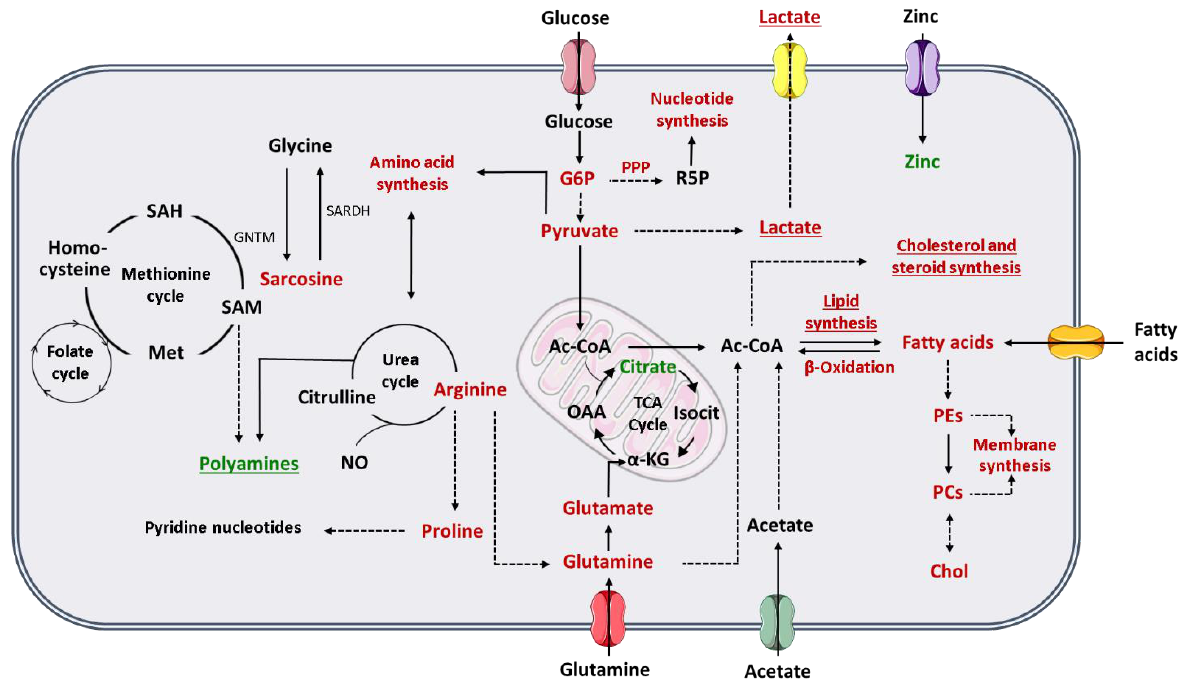
Figure 1. Schematic representation of the metabolic phenotype of prostate cancer cells. Red indicates increase in either metabolites or metabolic pathway flux and green indicates decrease in either metabolites or metabolic pathway flux. Underline indicates changes especially important in advanced PCa. The dashed lines represent multiple steps reactions. ( α -KG, alpha-ketoglutarate; Ac-CoA, acetyl-coenzyme A; Chol, choline; G6P, glucose-6-phosphate; GNMT, glycine N-methyltransferase; Isocit, isocitrate; Met, methionine; NO, nitric oxide; OAA, oxaloacetate; PCs, phosphatidylcholines; PEs, phosphatidylethanolamines; PPP, pentose phosphate pathway; R5P, ribose-5-phosphate; SAH, S-adenosylhomocysteine; SAM, S-adenosylmethionine; SARDH, sarcosine dehydrogenase; TCA cycle, tricarboxylic acid cycle).